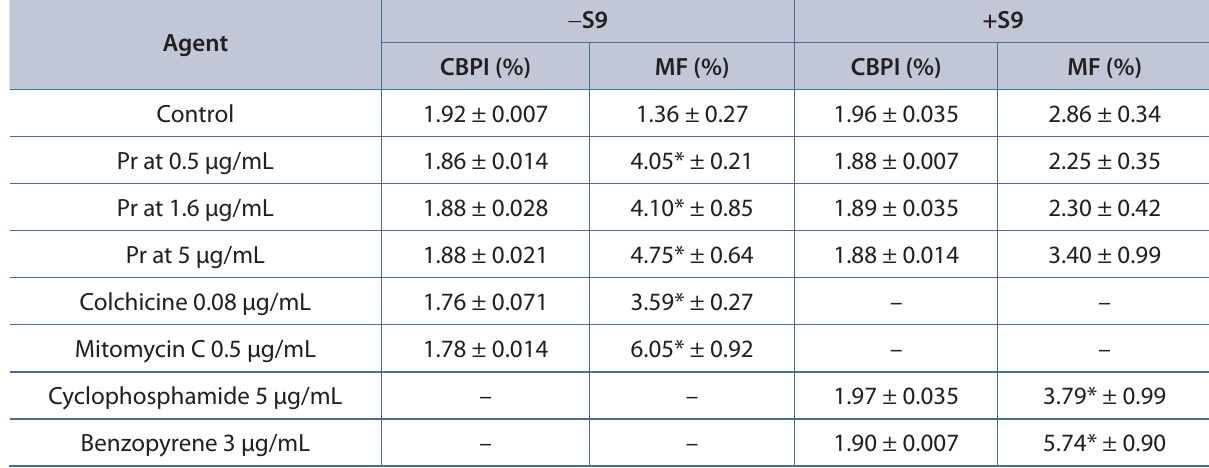
Table 2 . Micronucleus test (CHO-K1 line) and cytokinesis-block proliferation index (CBPI, mean ± SD). Values and the related micronucleus frequency (MF, %) of cells exposed to the Plathymenia reticulata Benth hydroalcoholic